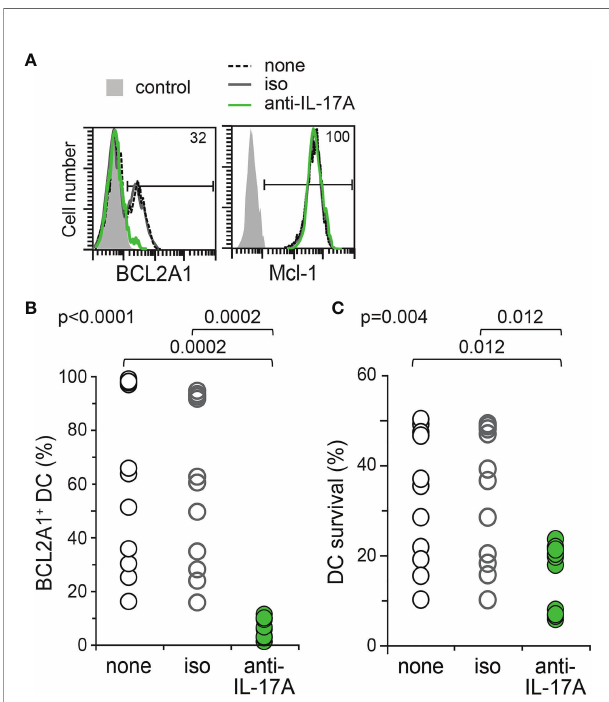
FIGURE 4 | BCL2A1 expression and survival of Mo-DCs from LCH patients after neutralization of endogenous IL-17A. Mo-DCs from LCH patients were cultured 7 days in the presence of either medium alone (none, Black) or IgG1 isotype control (iso, Grey) or neutralizing anti-IL-17A Abs (anti-IL-17A, Green). (A) Representative fl ow cytometry analyses of BCL2A1 and Mcl-1 intracellular staining. Percentages of positive Mo-DCs from LCH patient are indicated. Control ( fi lled grey histogram) corresponds to fl ow cytometry isotopic control. (B) Percentage of intracellular BCL2A1 expression in the Mo-DCs from all LCH patients tested. (C) Percentage of DiOC + 6 PI – viable Mo-DCs from the LCH patients per million cultured Mo-DCs. (B, C) The mean of triplicate values was plotted for each patient. SD were below 2%. One symbol corresponds to one patient. Mo-DCs from 11 LCH patients (p1b, p2b, p7c, p6b, p9, p12, p13, p14, p16, p19, p20) were analysed. Statistical analyses: the Kruskal-Wallis test with Steel-Dwass-Critchlow-Fligner post-test were used to compare the groups and calculate the p